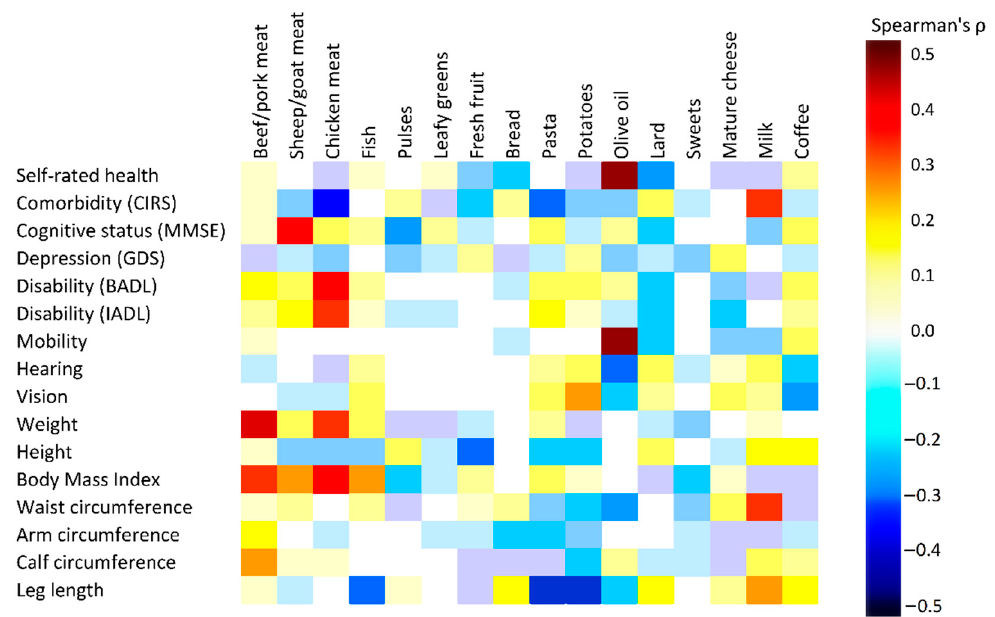
Figure 4. Spearman correlation heat map for the association between variation of food frequency across nutrition transition and health indicators.